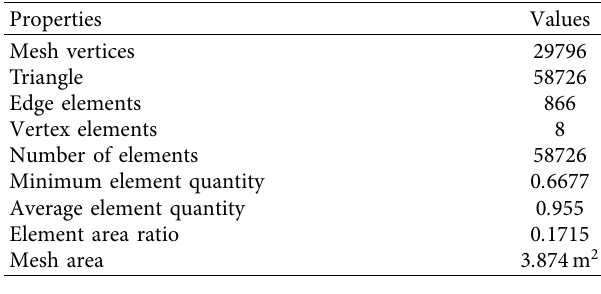
Figure 3: The velocity magnitude computation on different number of elements. Table 1: Mesh statistics for extra finer mesh ( N �